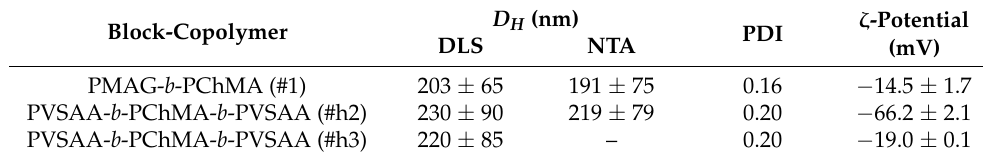
Table 2. Characteristics of the nanoparticles self-assembled from amphiphilic block-copolymers.